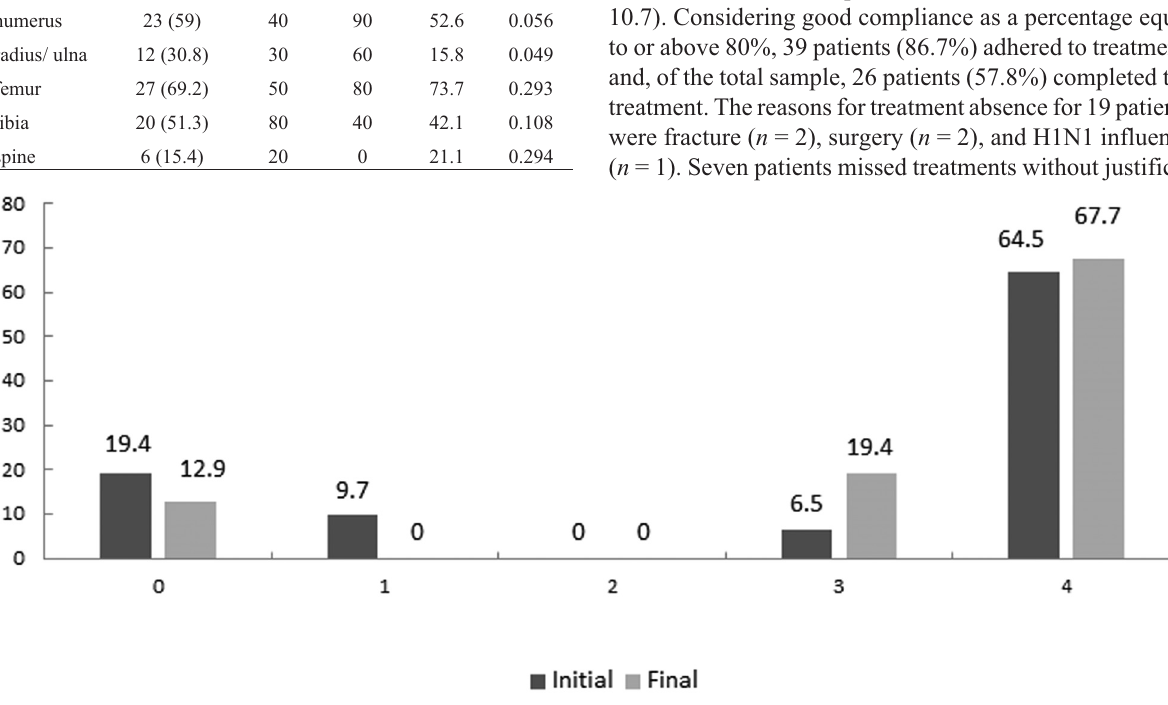
Figure 2 - Mobility score criterion system (Land et al. (2006): (0) restricted to wheelchair; (1) able to walk with assistance; (2) able to walk at home with or without assistance; (3) able to walk short distances with or without assistance; and (4) able to walk